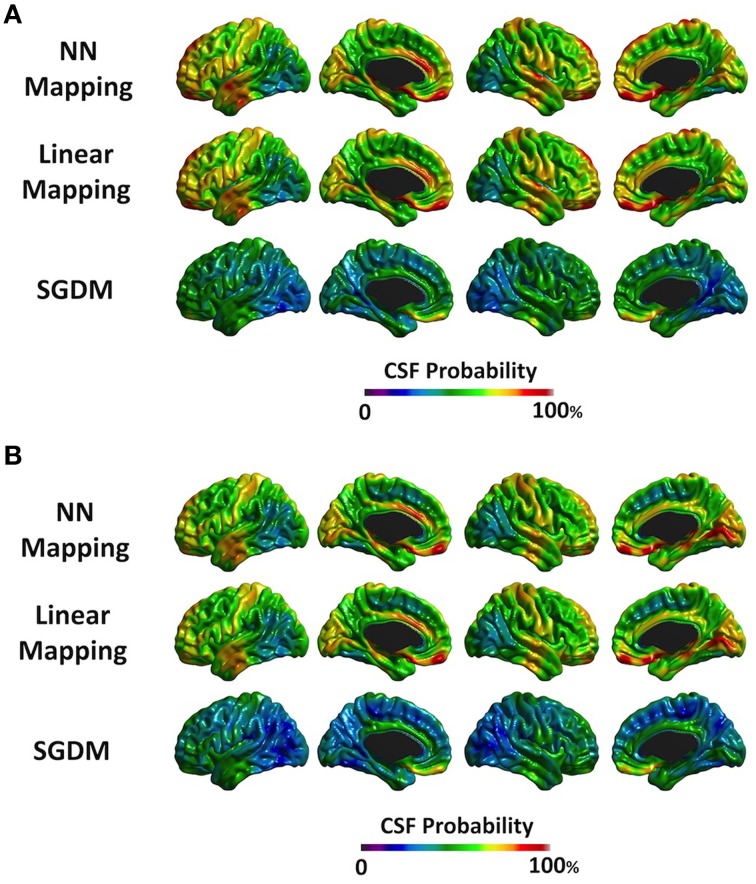
The probability map of the CSF tissue class. The color scale on the bottom represents the probability of being classified as CSF. (A) The results of ANTs-SyN registration. (B) The results of affine registration.